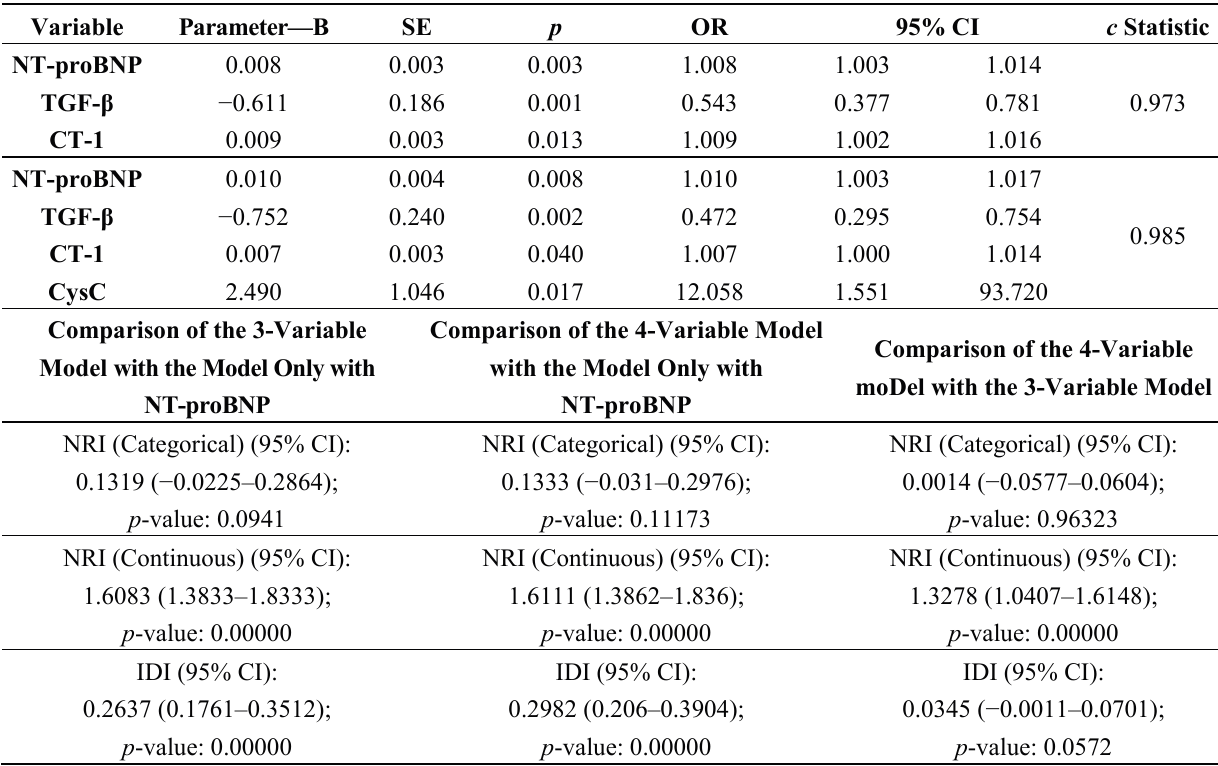
Table 7. Independent risk factors for heart failure in progressing logistic